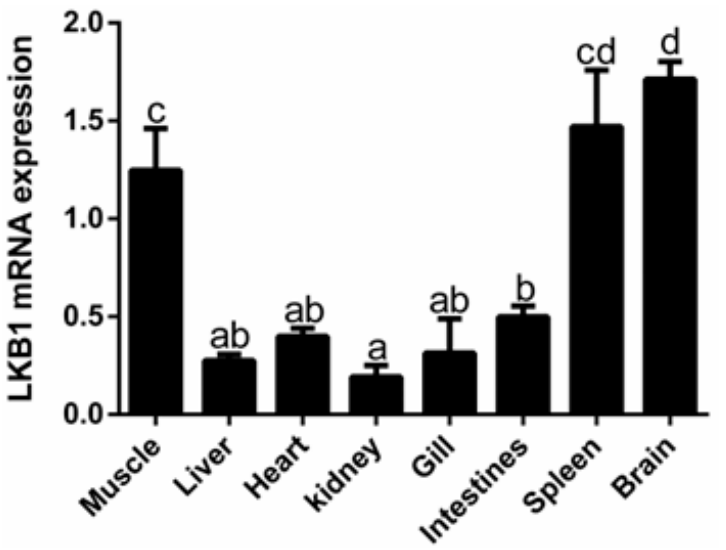
Figure 2. Relative mRNA expression levels of LKB1 in different tissues. Data are presented as means ± SE ( n = 3). Different letters indicate significant differences ( p < 0.05).